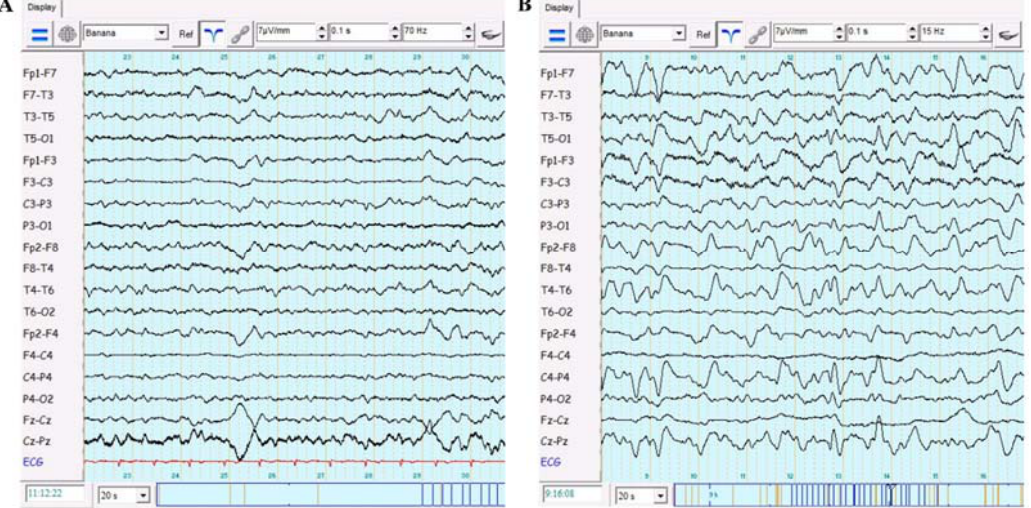
Figure 2. Electroencephalography (EEG). The EEG before the SARS-CoV-2 infection showing bilateral intermittent slowing ( A ). The EEG recording performed nearly one month after the onset of SARS-CoV-2 infection demonstrating bilateral quasiperiodic 1–2 Hz epileptiform discharges with biphasic and triphasic morphology ( B ).